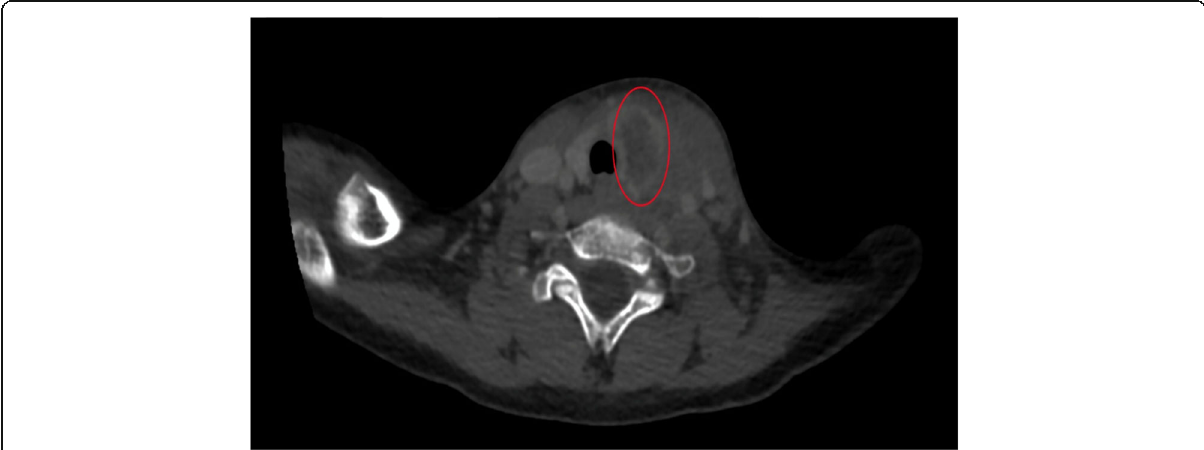
Fig. 3 CT scan of neck depicting left lobe of thyroid replaced by hypodense lesions of fluid attenuation (red demarcated circle area); features suggestive of acute suppurative